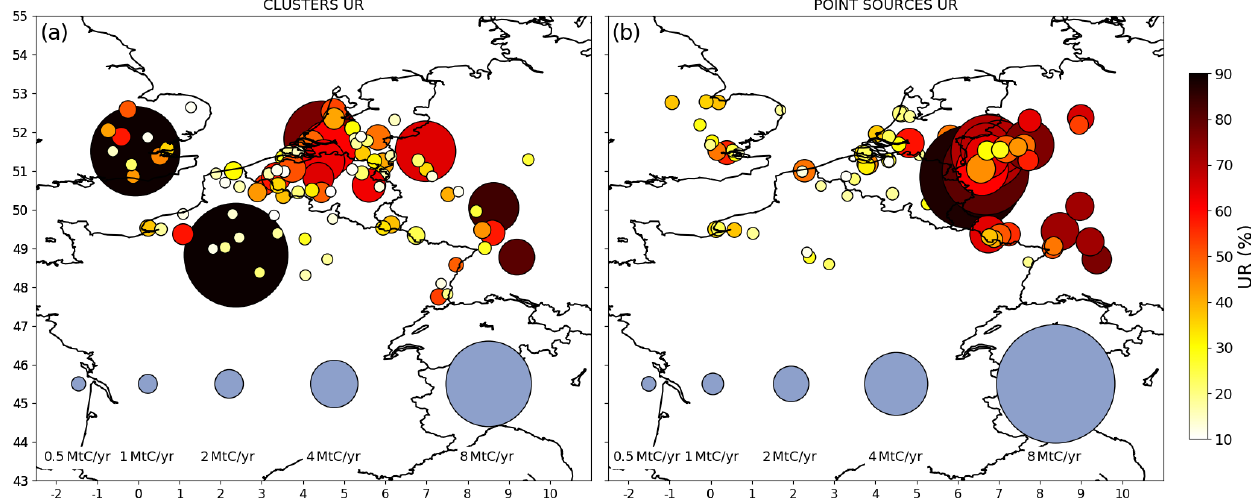
Figure 6. Mean uncertainty reductions (UR) for some city clusters (a) and some point sources (b) across the 62 inversion results for the days of March and May 2016. The areas and colors of the disks represent the annual emissions (MtCyr − 1 ) and the UR (%), respectively. The inversions are performed with a retrieval resolution of 2km × 2km, a precision of 0.6ppm and a swath of 900km. Prior uncertainties on 6h budgets of clusters and point sources emissions are taken to be equal to 50%, and prior error correlations have a temporal length of